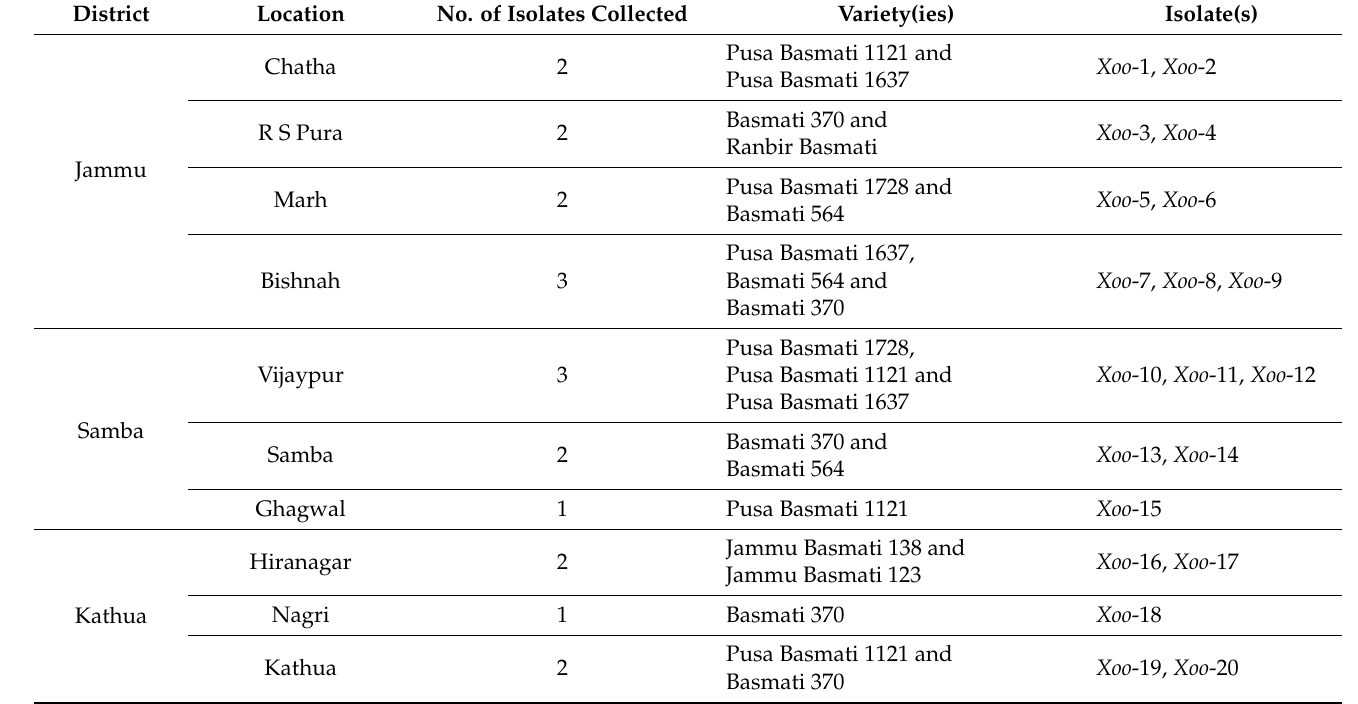
Table 2. Xanthomonas oryzae pv. oryzae isolates collected from Jammu